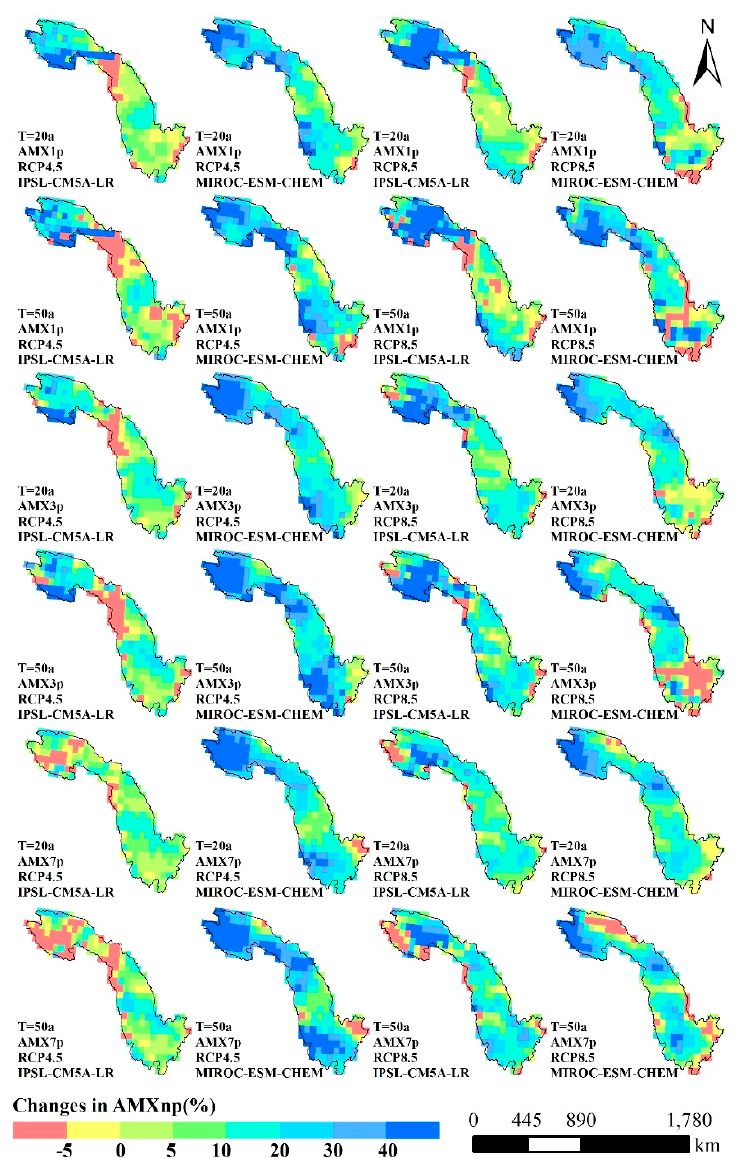
Figure A1. Changes in AMX1p, AMX3p and AMX7p with 20-/50-year return period from baseline to future.